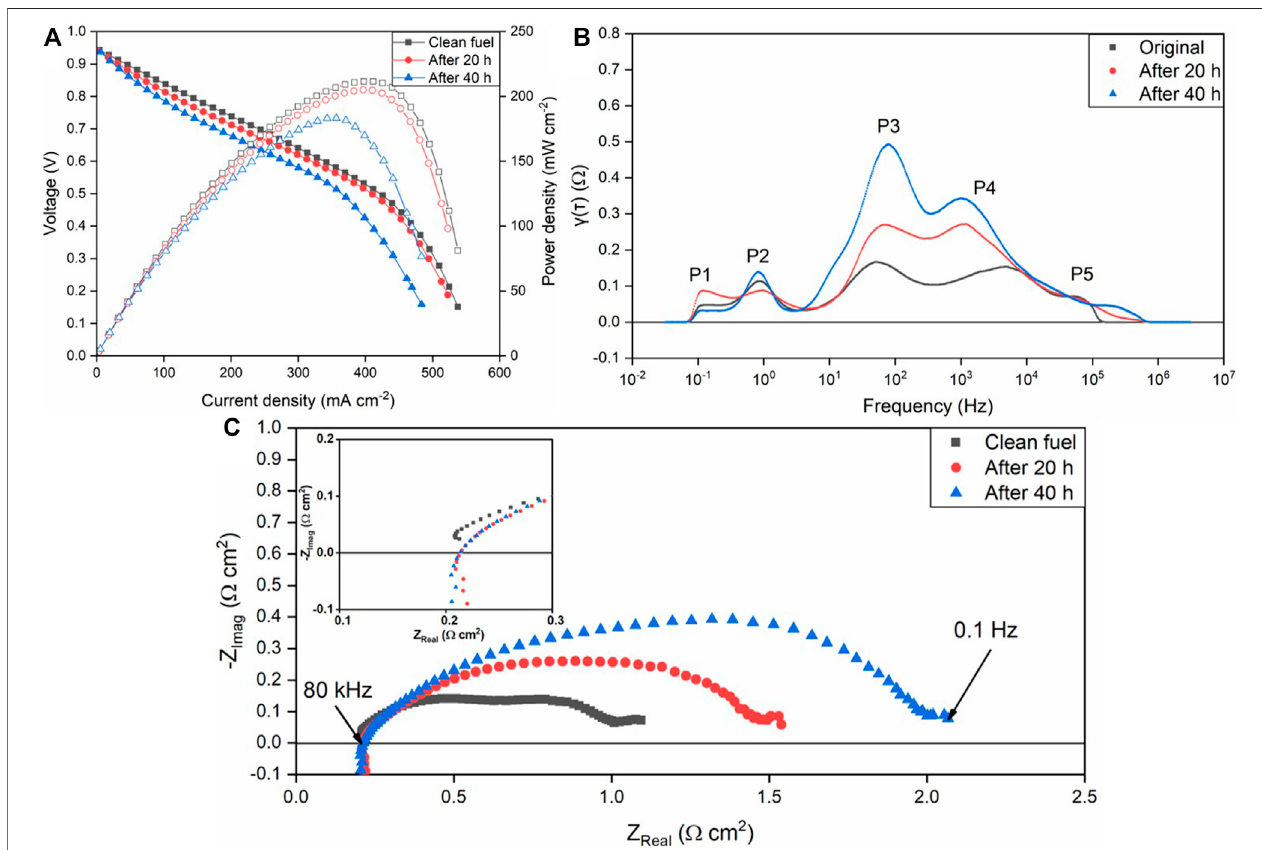
FIGURE2| PerformancedegradationoftheSOFCduetoD4contaminationwithH 2 +N 2 +D4asthefuelat750 ° C. (A) polarizationcurve; (B) EISmeasurements; (C) DRT plot.